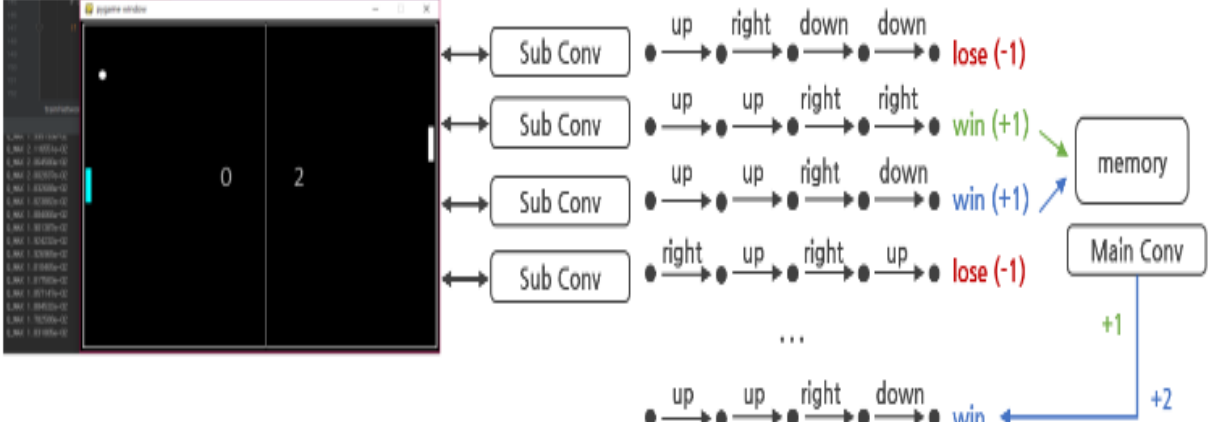
Figure 13. The result of a 10 × 10 maze game through N-DQN.